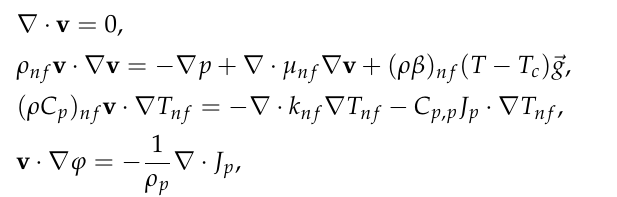
ND + 1 j NY /2 + ND + 1, − ≤ ≤